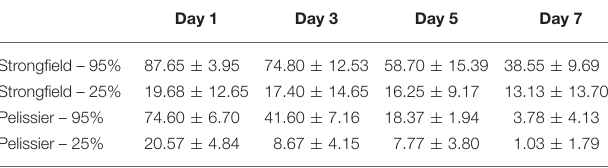
TABLE 1 | Water content remaining in root boxes after withholding